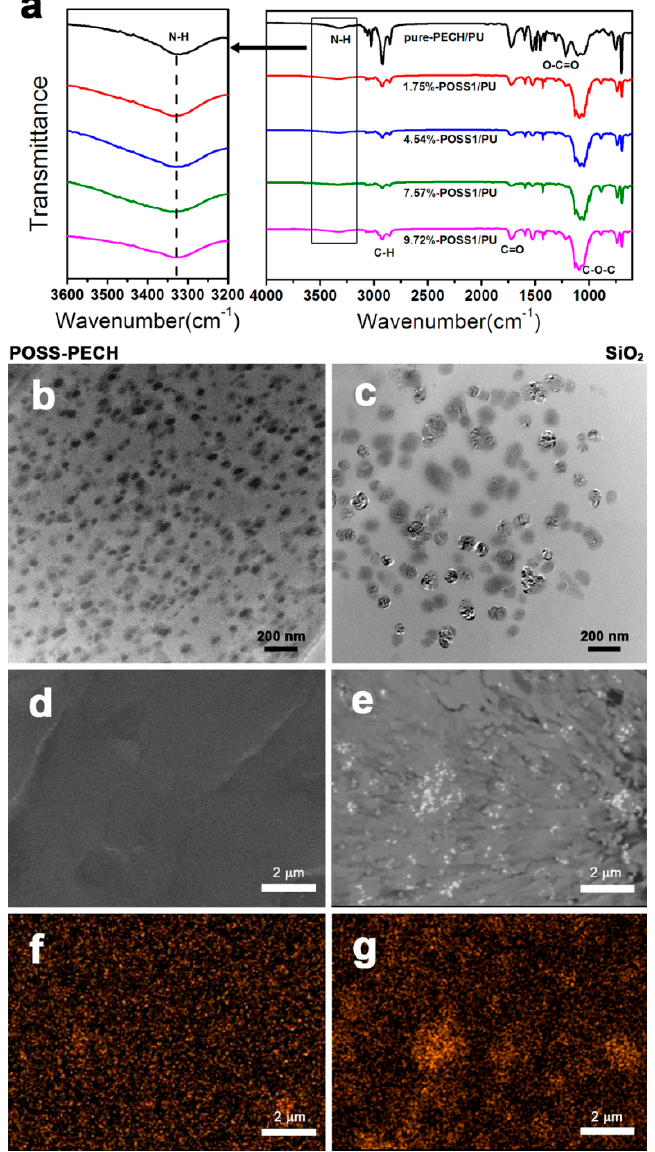
Figure 3. ( a ) FTIR spectra of PUs with different POSS contents. ( b ) TEM images of 9.72% POSS-modified PU. ( c ) TEM images of 9.74% SiO 2 -modified PU. ( d ) SEM images of 9.72% POSS-modified PU. ( e ) SEM images of 1.96% SiO 2 -modified PU. ( f ) Element mapping images of Si 9.72% POSS-modified PU. ( g ) Element mapping images of Si 1.96% SiO 2 -modified PU.